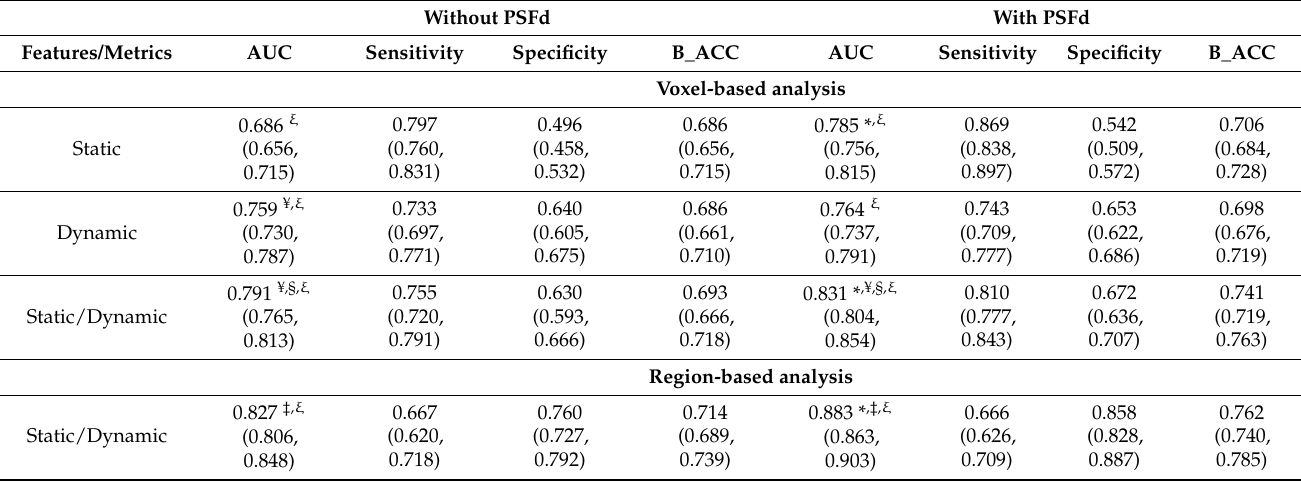
Table 2. Model performance on the test set for IDH-mutation